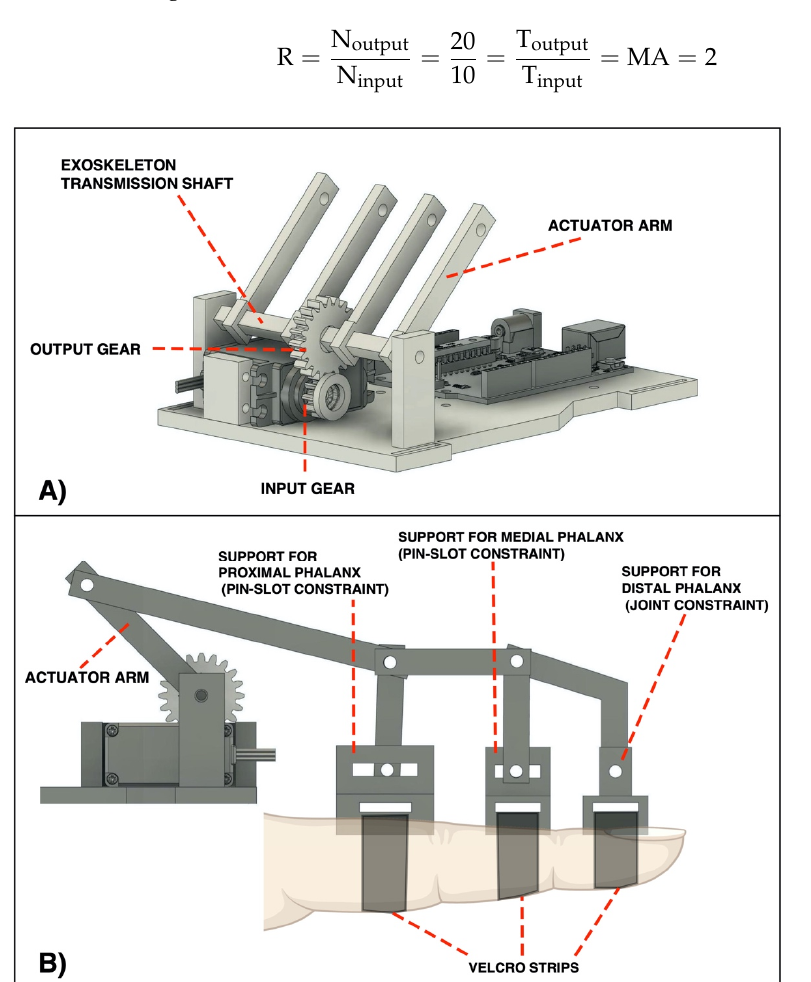
Figure 2. The 3D renderings of the components of the exoskeleton: ( A ) focus on the mechanical transmission system from the servomotor to the finger actuator arms; ( B ) side view of the rigid transmission system coupled to a finger, showing the supports (and the constraints) realized for each phalanx.